Question: Provide a publication-style caption for this figure.
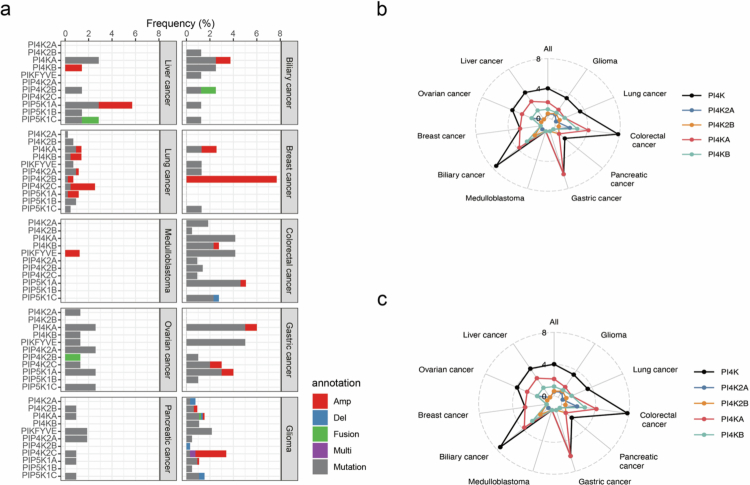
Answer: The alteration landscape of PI4K and PIPK family genes across different cancer types. a, Mutation types of individual PI4K and PIPK family genes in various cancers. The bar plot shows the frequency of alterations, categorized as Amplification (Amp), Deletion (Del), Fusion, Multi-mutation (Multi), or Mutation. b-c, Alteration frequencies of PI4K (b) and PIPK (c) family genes across cancer types.